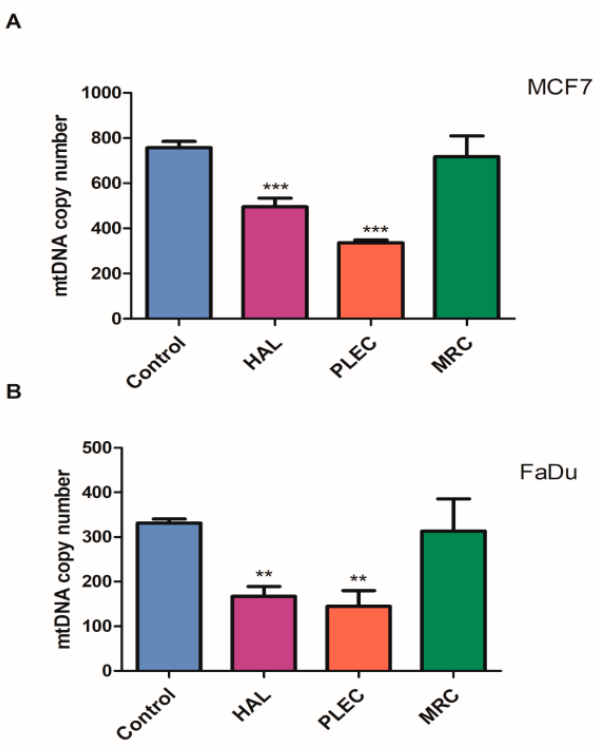
Figure 5. ( A , B ). Mitochondrial DNA copy number in MCF7 ( A ) and FaDu ( B ) cells measured by real-time quantitative PCR. The cells were exposed to HAL, PLEC and MRC and, after 24 h of incubation, DNA was extracted. Values are expressed as the means ± SD. ** p < 0.01, *** p < 0.001 vs. control